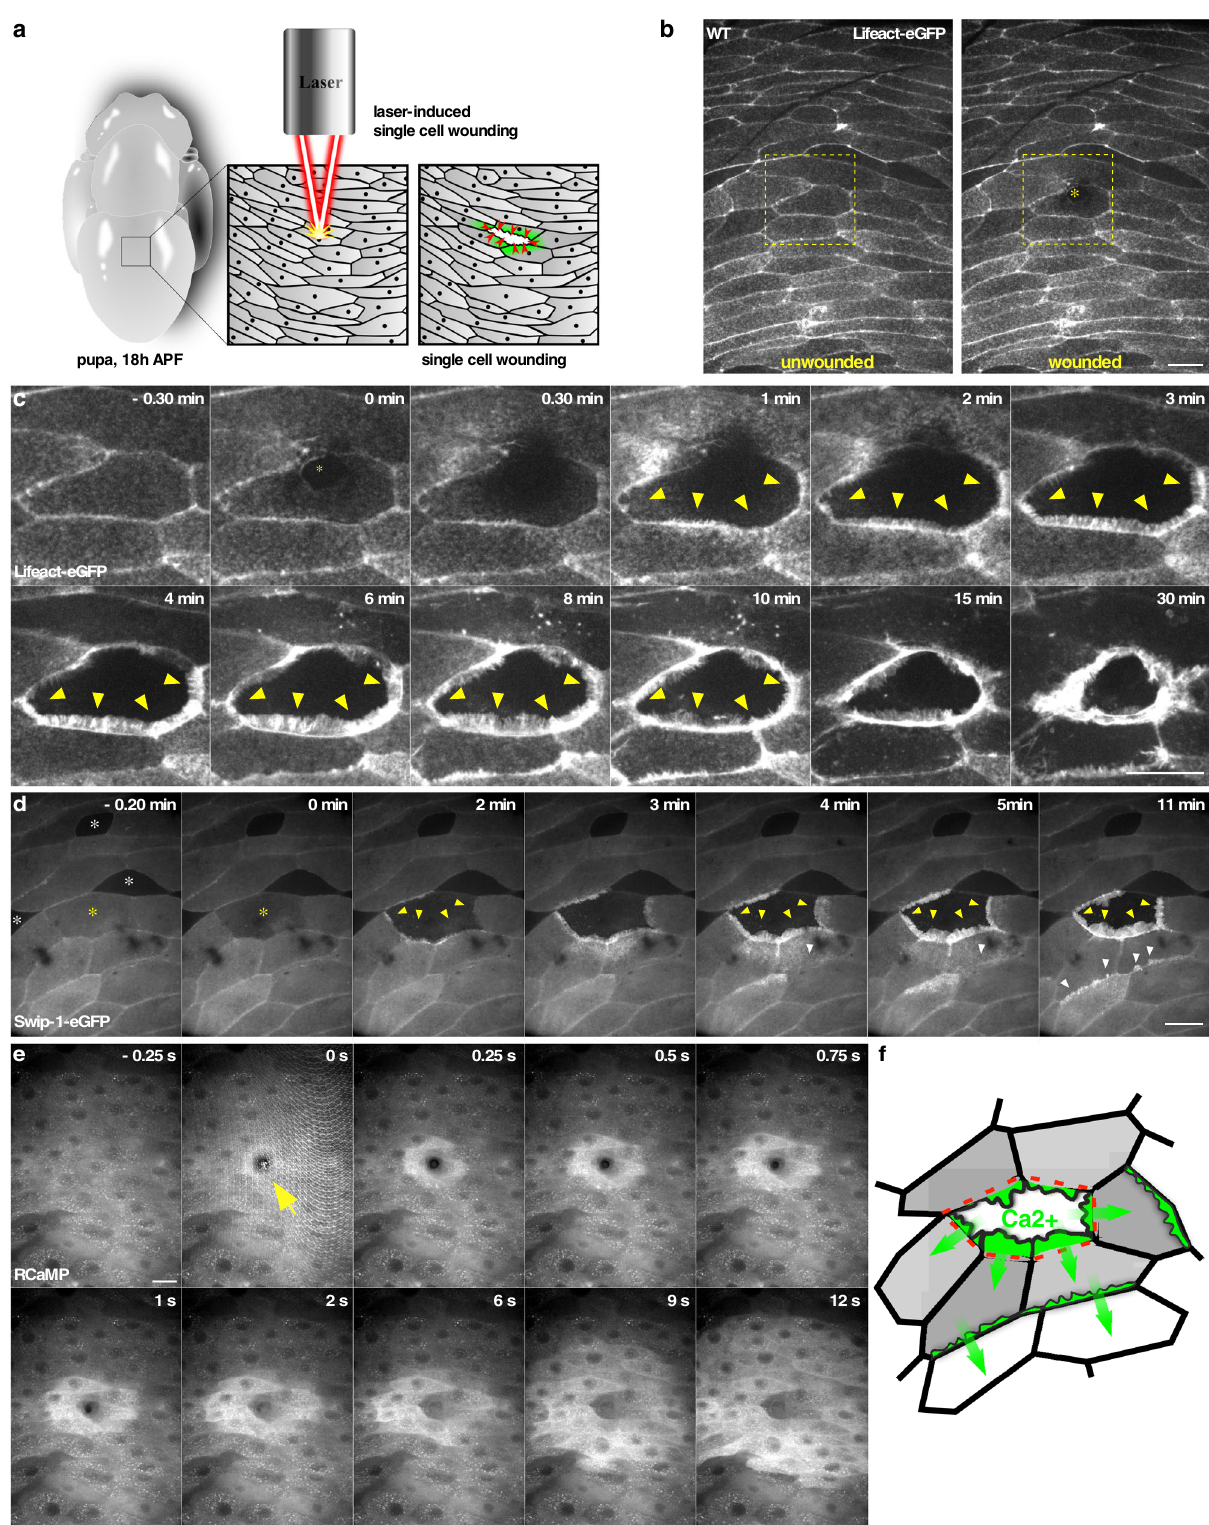
Supporting this notion, we found that forced overexpression of Swip-1 stabilizes protrusions at the expense of migration speed in vivo. Thus, the assembly of cross-linking proteins such as EFhD2/Swip-1 into the branched actin network might contribute to a resistance-adaptive behavior of migrating cells as recently proposed 56